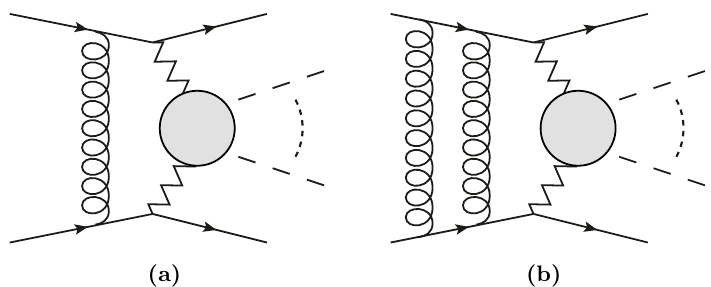
Figure 6. Generic form of non-factorisable 1-loop (a) and 2-loop (b) corrections to the production of n Higgs